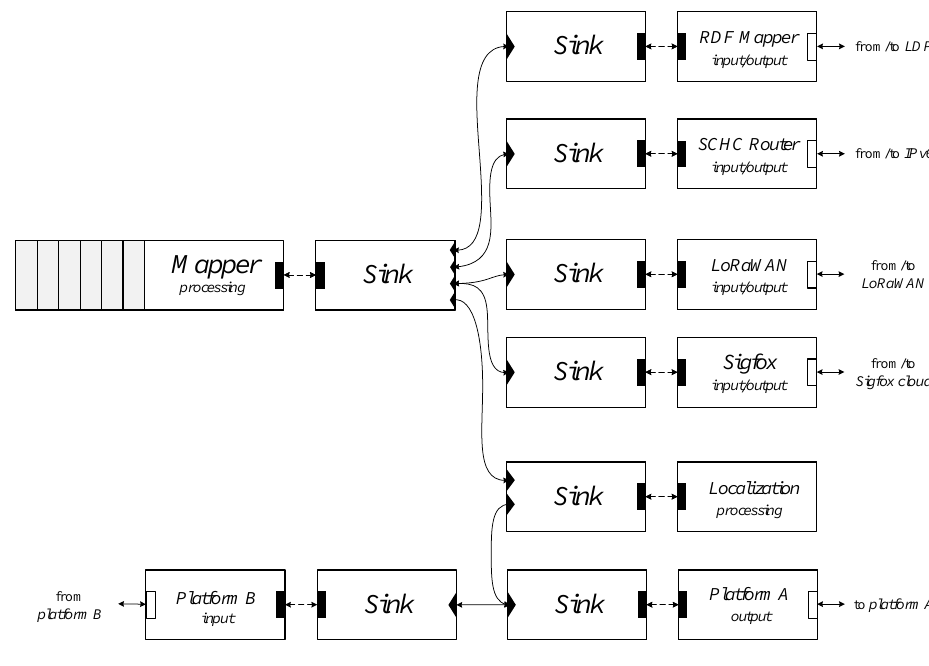
Figure 5. More complex system configuration. Every sink is connected to others via the message bus. The Mapper adapter implements a